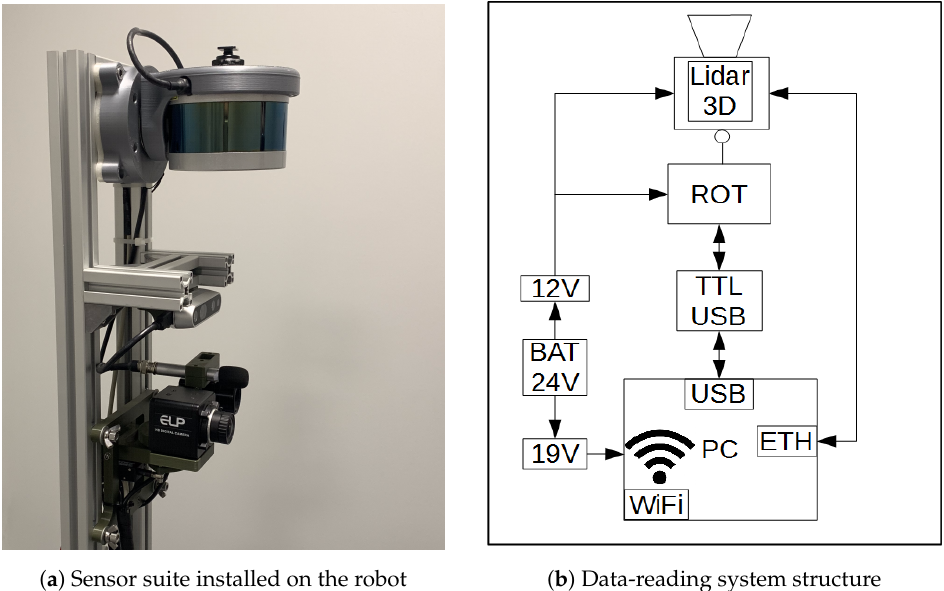
Figure 1. Adjustable mapping system for the mobile